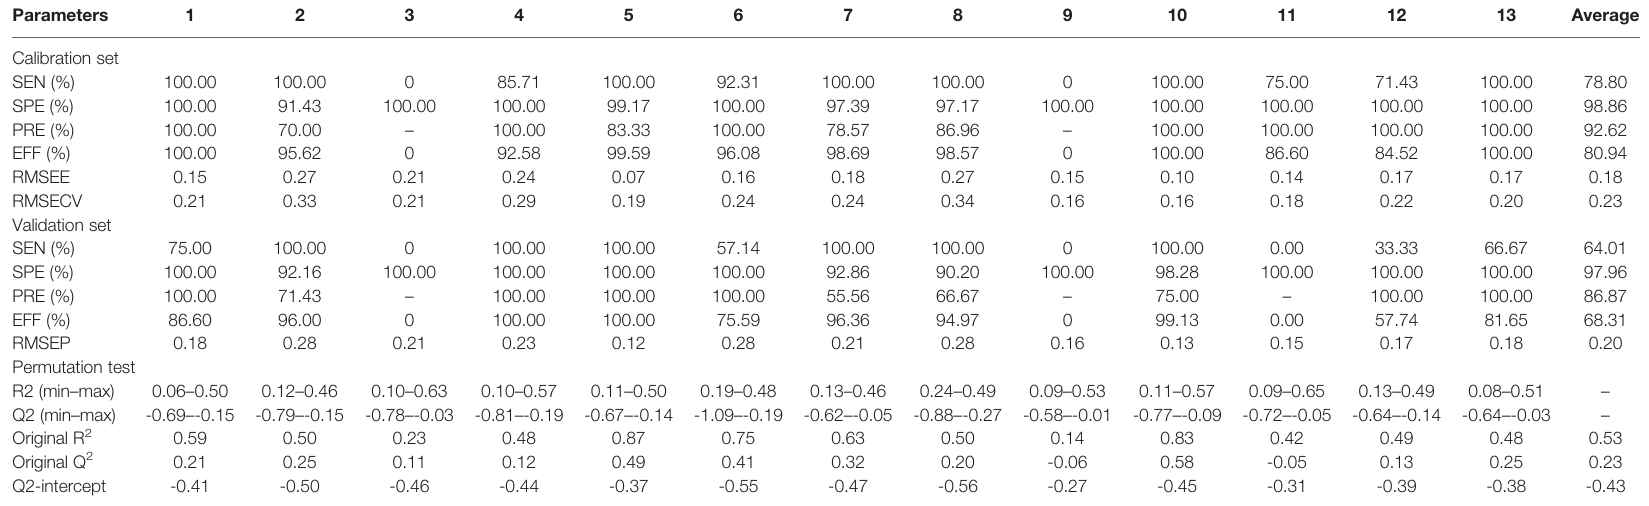
TABLE 4 | Classi fi cation parameters obtained for PLS-DA model using mid-level fusion of EUL with different collection regions. Parameters Calibration set SEN